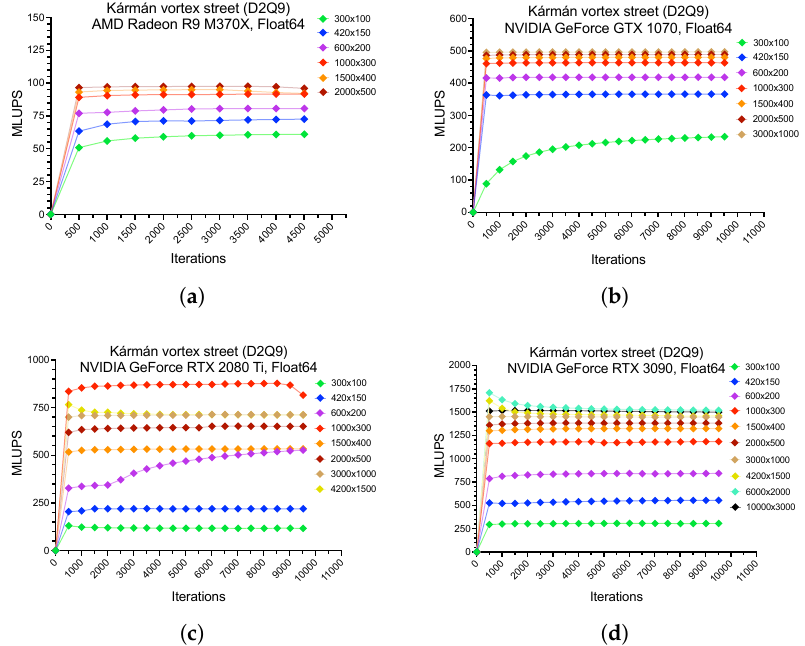
Figure 8. Double-precision performance analysis of 2D Kármán vortex on D2Q9 stencil. ( a ) Perfor- mance on Radeon R9 M370X GPU; ( b ) Performance on GTX 1070 GPU; ( c ) Performance on RTX 2080 Ti GPU; ( d ) Performance on RTX 3090